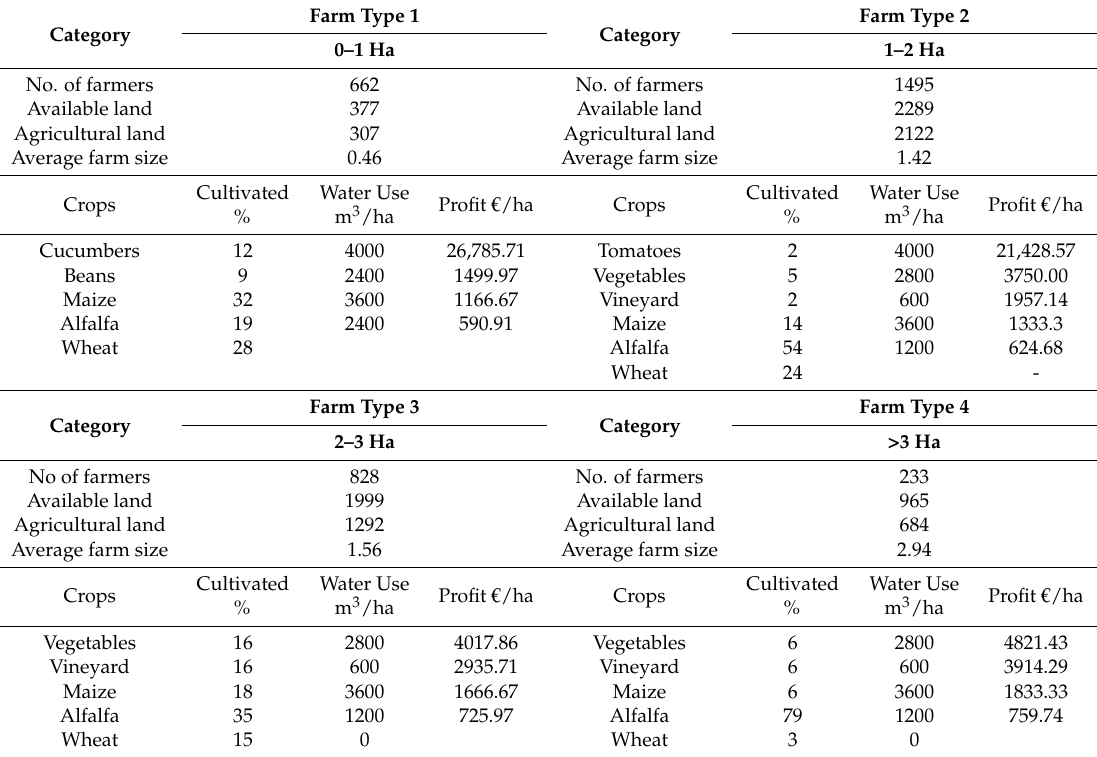
Table 1. Main characteristics of farm